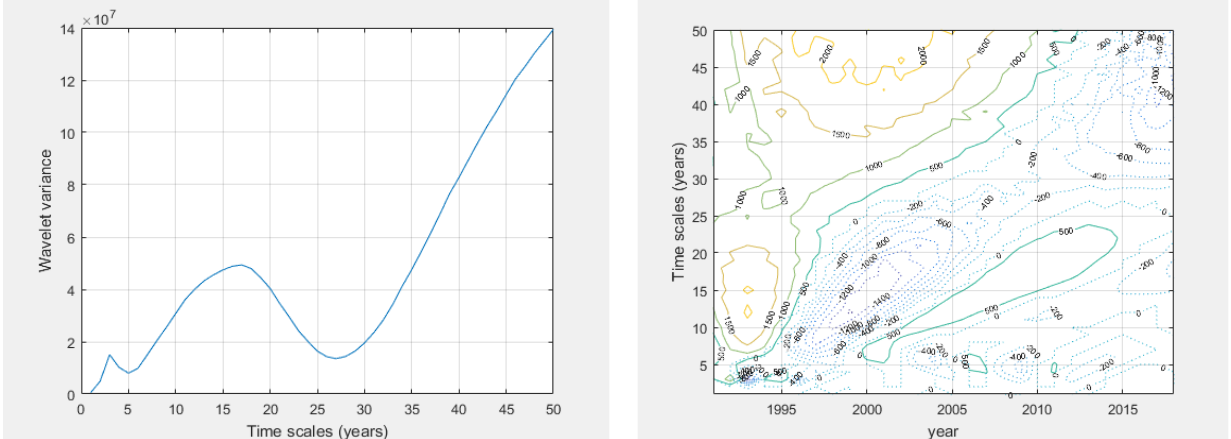
Figure 11. Wavelet variogram and coefficient real contours of the number of livestock with reduced drinking water owing to drought in China, 1991–2018.